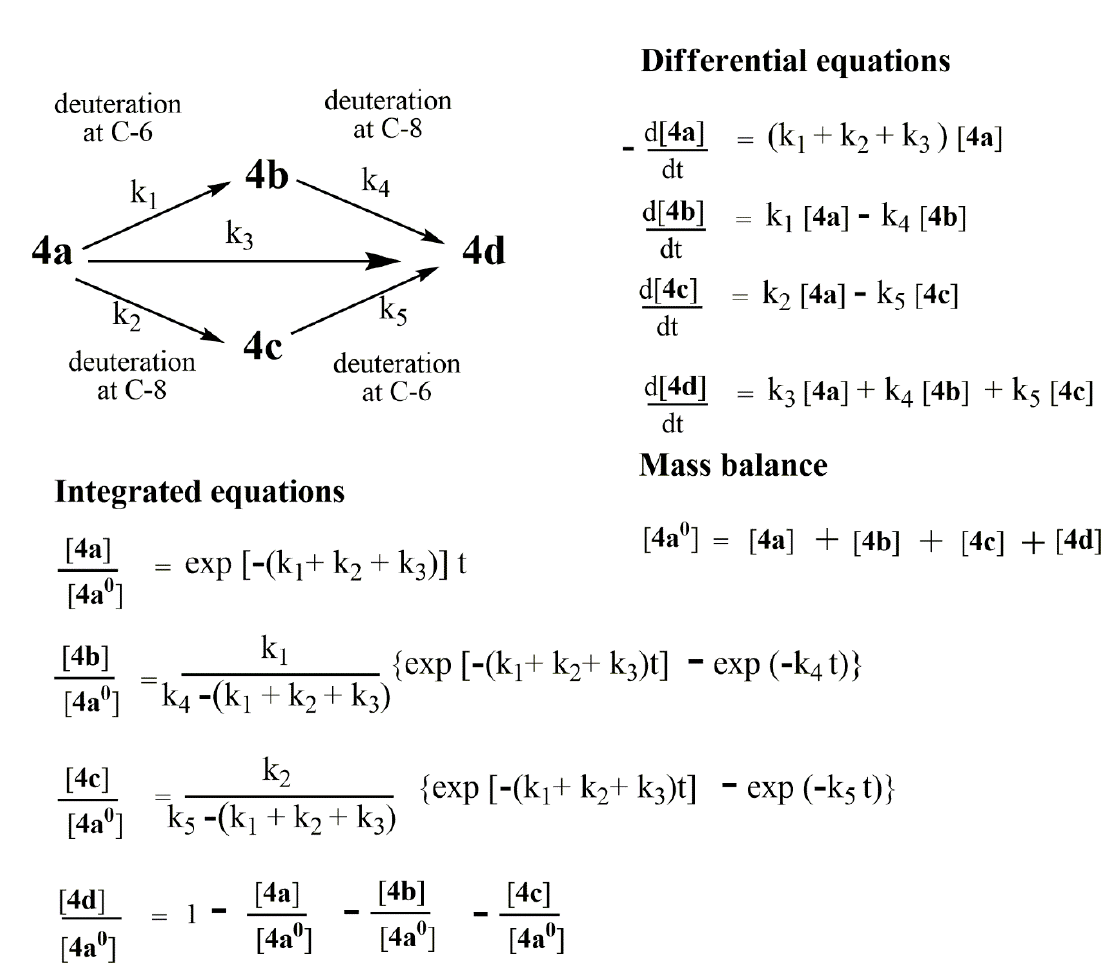
Scheme 3. Reaction scheme of the five steps involved in the deuteration of catechin by D 2 O (top, left); differential (top, right) and integrated (bottom) kinetic laws assuming pseudo-first-order processes.